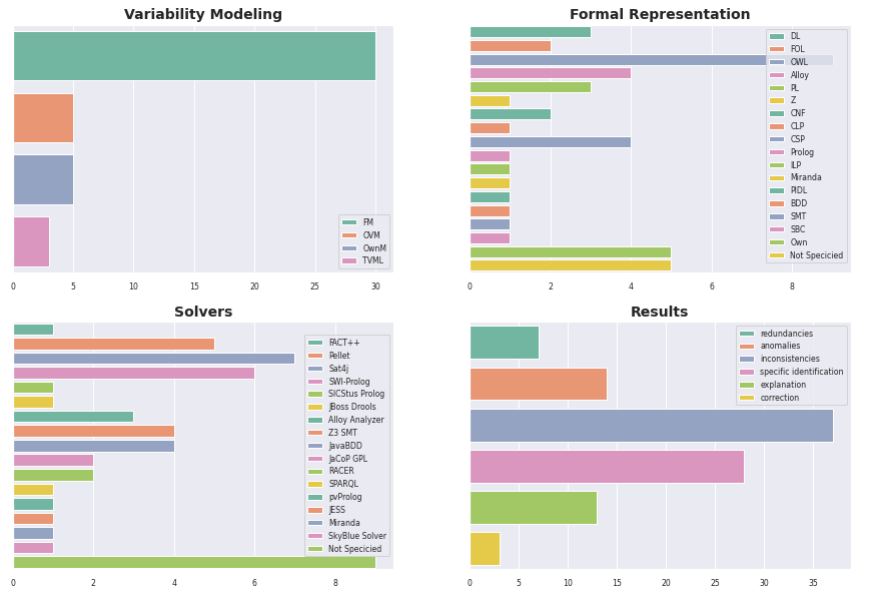
Figure 2. Number of different approaches addressing each component of the VA